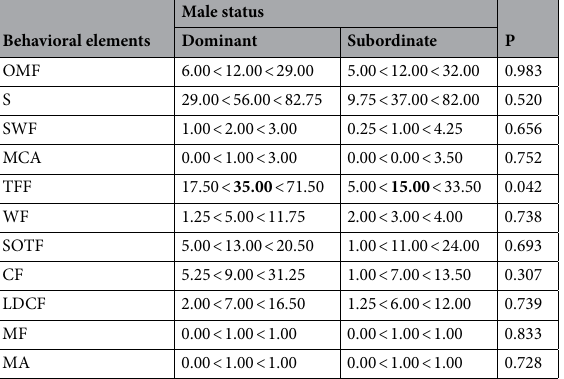
Table 2. Frequencies of courtship behavioral elements of Anastrepha curvicauda dominant and subordinate males (7–8 days old) caged with a virgin 5–7 days old female. Non-choice experiment. Reported values are Q1 < Median < Q3 (n = 15). Medians in bold in the same row are significantly different (Mann–Whitney test, p > 0.05). See Table 1 for abbreviations.